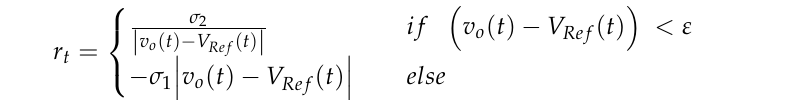
Table 1. Parameters of the EPBC. Parameters 20 μ F Table 2. Parameters of the controllers. Parameters